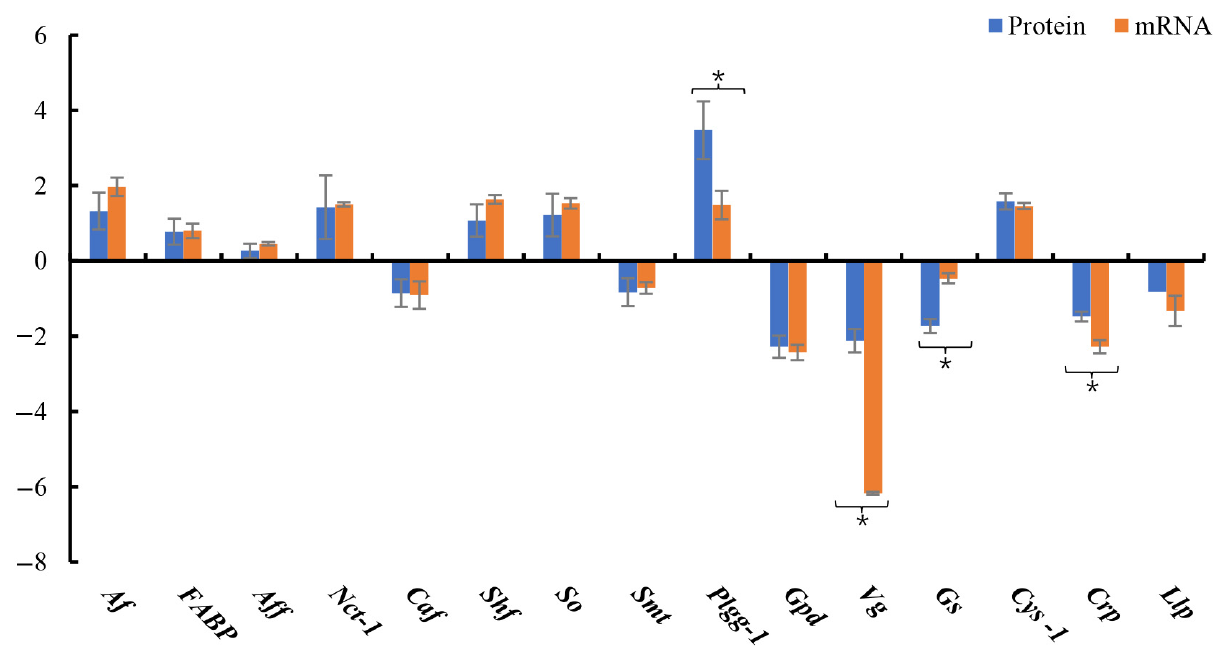
Figure 7. qPCR validation. Comparison of the selected genes by Protein-Seq and qPCR. The fold changes were calculated by 2 − ∆∆ CT . Data are shown as means ± SD ( n = 3). * means significant differences ( p < 0.05).